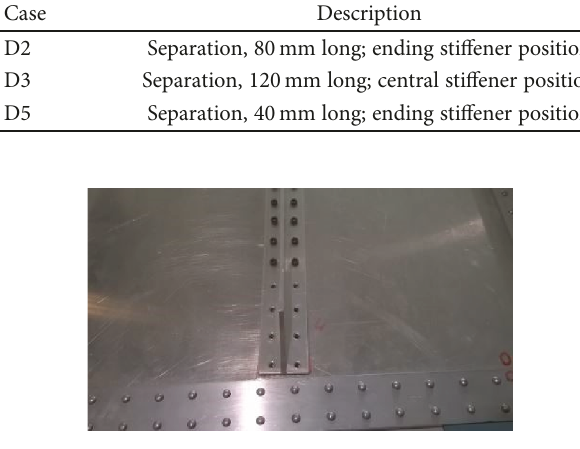
Figure 5: Detail of D2 damage.